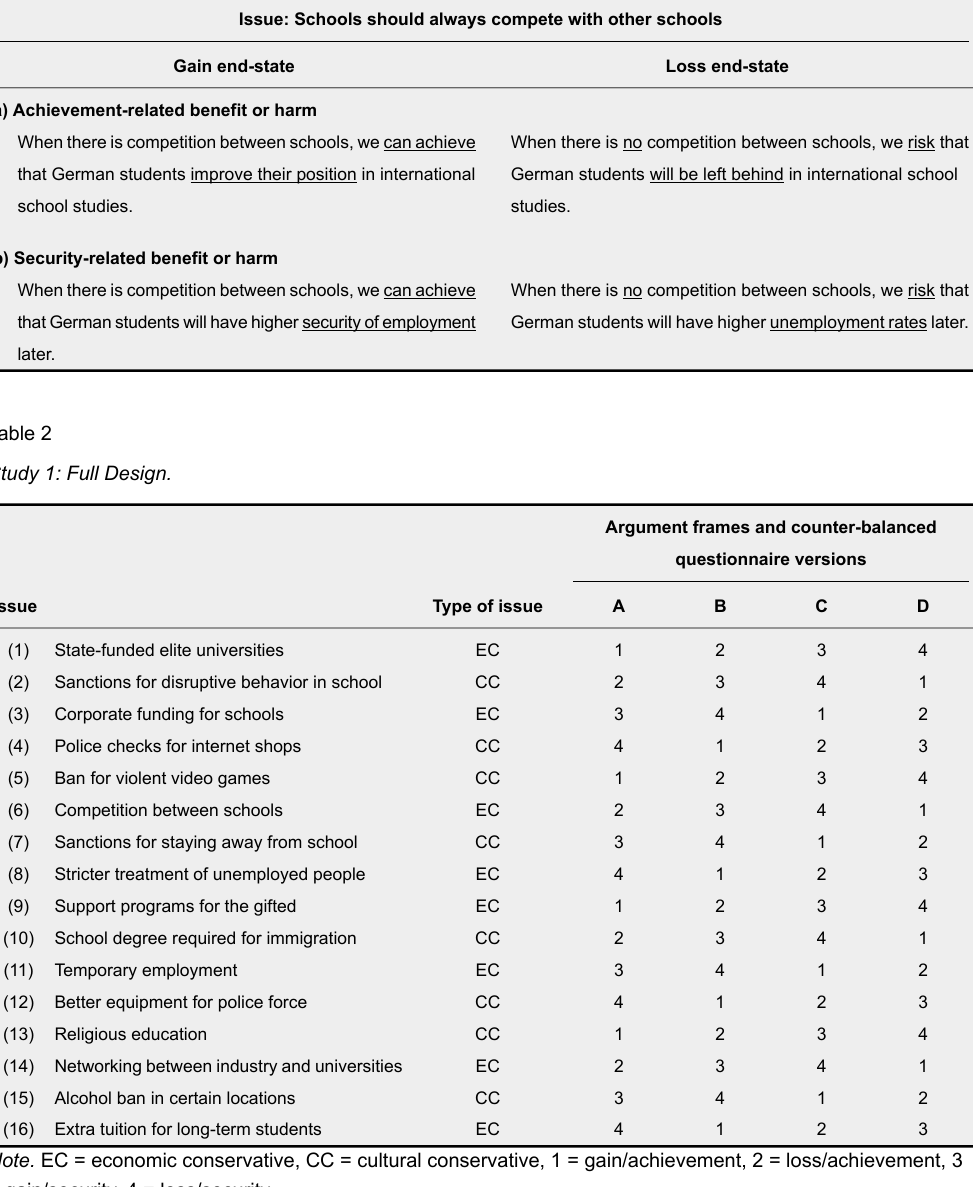
Example Arguments for an Economic Conservative Issue Issue: Schools should always compete with other schools